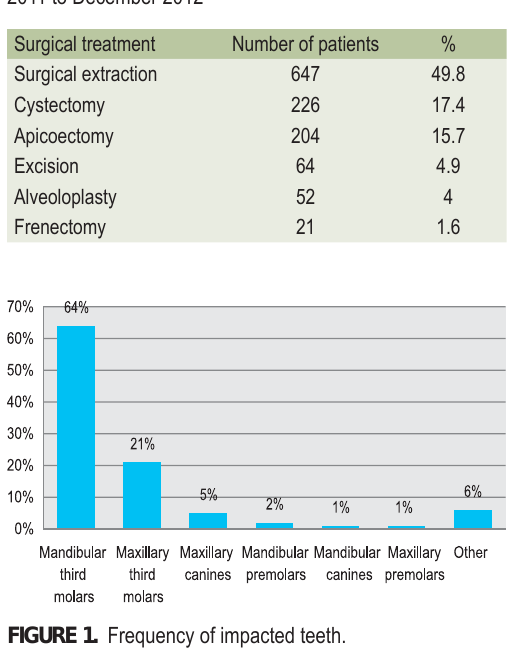
FIGURE 1. Frequency of impacted teeth.